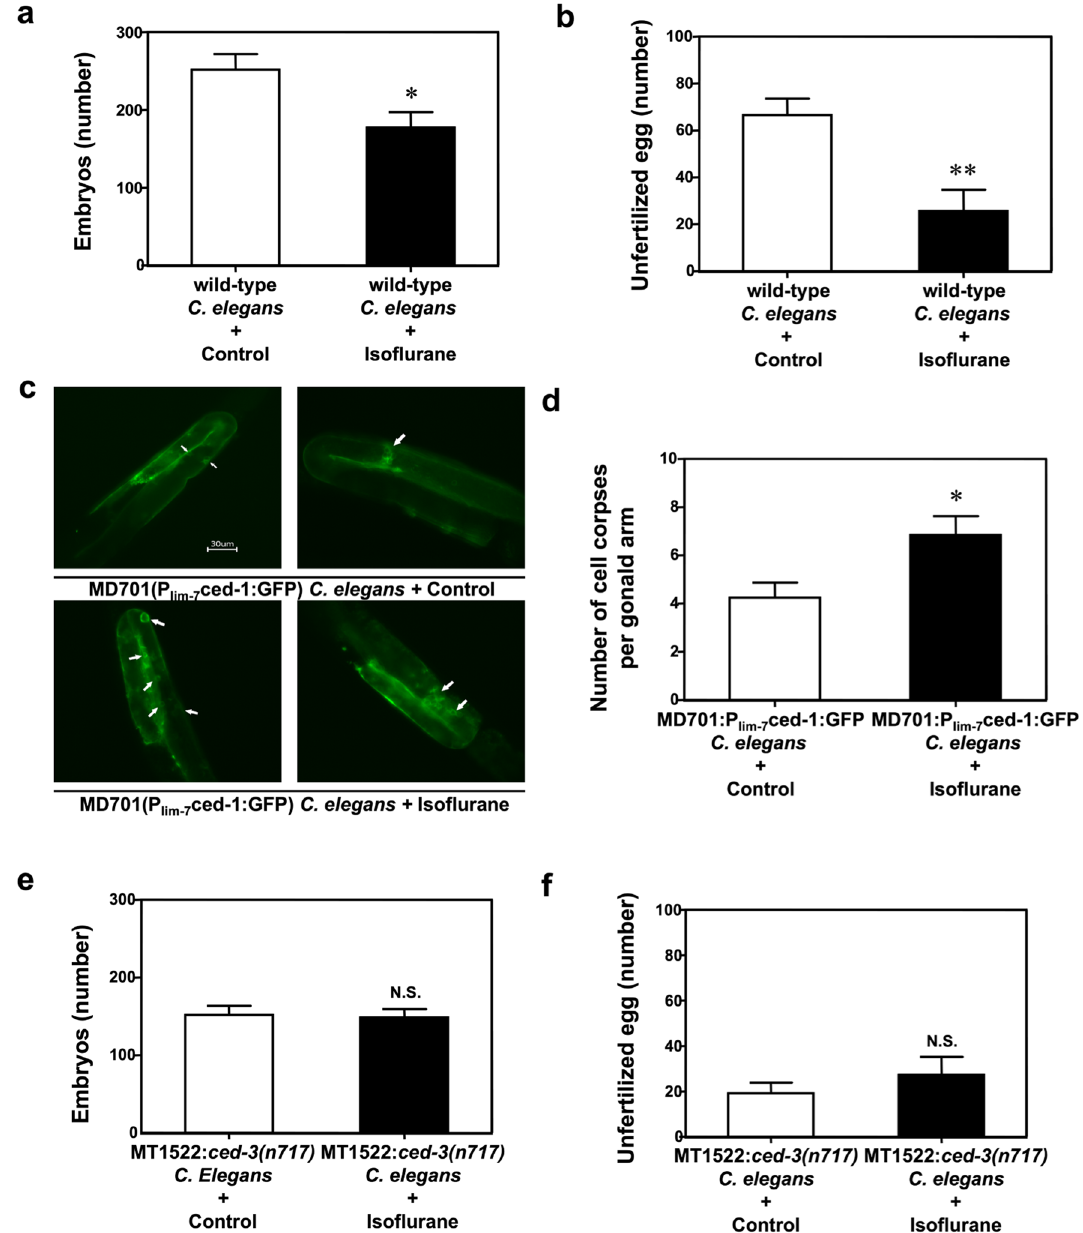
Figure 1. Isoflurane impaired oogenesis in C. elegans . ( a ) Treatment with 7% isoflurane for 4 h decreased the number of embryos produced by N2 hermaphrodites. ( b ) Treatment with 7% isoflurane for 4 h decreased the number of unfertilized eggs produced by N2 hermaphrodites. ( c ) Fluorescence microscopy of representative dead cells (at day one with 400 × magnification using z-stacking) produced by adult day-1 MD701 hermaphrodites. Arrows indicate dead cells with the green halo. Scale: 30 µm. ( d ) Quantification of dead cells produced by adult MD701 hermaphrodites at day one. Isoflurane increased the number of dead cells. ( e ) Treatment with 7% isoflurane for 4 h did not decrease the number of embryos produced by ced-3 knockout hermaphrodites. ( f ) Treatment with 7% isoflurane for 4 h did not decrease the number of unfertilized eggs produced by ced-3 knockout hermaphrodites. All data are presented as mean ± S.D. N = 10 hermaphrodites in each group. The Student’s t-test was used to analyze the data presented in ( a , b , d – f ); the P values refer to the difference between the control condition and isoflurane treatment. * P < 0.05, ** P < 0.01. N2: wild-type C. elegans . MD701: C. elegans strain bcls39 V . MT1522: C. elegans strain ced-3(n717)